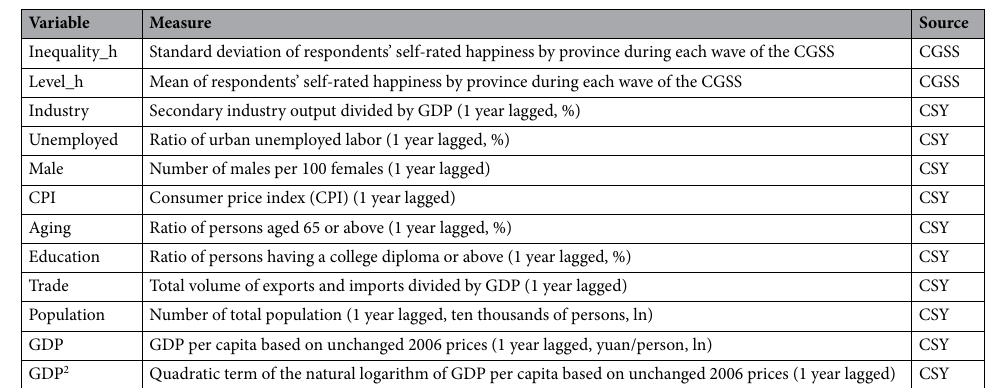
Table 1. Measures of variables. CSY China Statistical Yearbooks. Ten waves of CGSS were used 41 , which